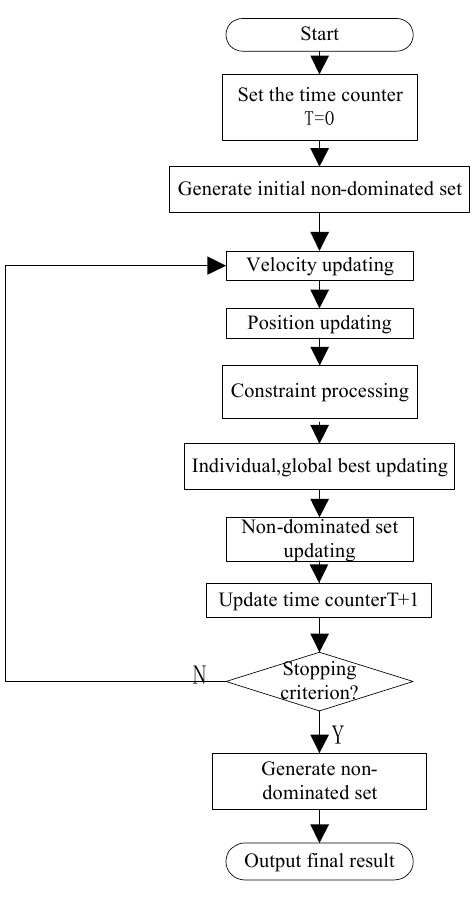
Figure 2. The flowchart of DEMPSO.